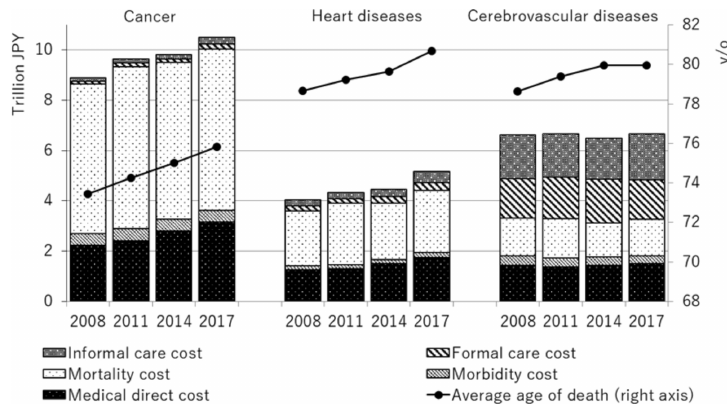
Figure 2. The time trends of